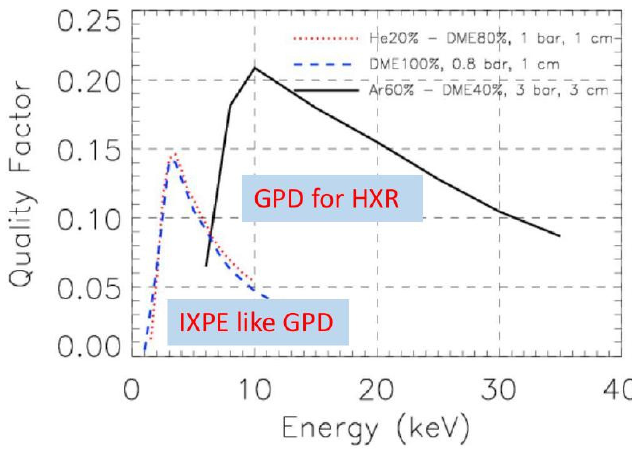
Figure 6. Quality factor for different configurations of the